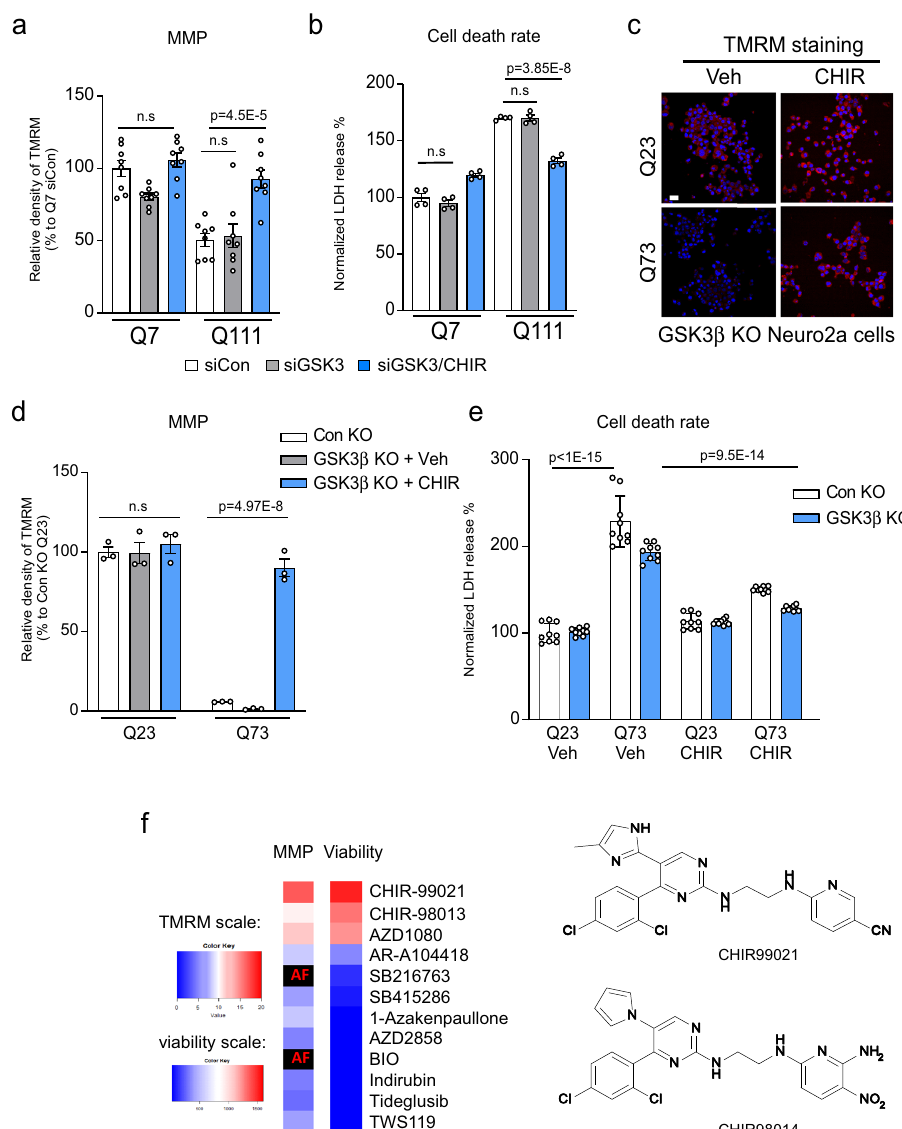
Fig. 3 The protective effects of CHIR99021 in HD is independent of GSK3. HdhQ7 and HdhQ111 cells were transfected with small interfering RNA (siRNA) control (siCon) or GSK3 (siGSK3) for 3 days, followed by CHIR99021 (3 µ M) treatment for 48 h. a Mitochondrial membrane potential (MMP) was examined by TMRM staining; quanti fi cation of TMRM density is shown ( n = 8). b Cell death was measured by lactate dehydrogenase (LDH) release after 16 h serum starvation ( n = 4). Neuro2a cells were transfected with vectors expressing control guide RNA (gRNA) or GSK3 β gRNA and Cas9. After con fi rming GSK3 knockout (Supplementary Fig. 3c), cells were transfected with Myc-tagged Q23-Htt (Q23) or Q73-Htt (Q73) constructs for 12 h, followed by a 2-day incubation with CHIR99021 (3 μ M) or vehicle (Veh). c Representative TMRM images of the indicated groups. Scale bar = 30 μ m. d Quanti fi cation of TMRM fl uorescence density is shown ( n = 3). e Cell death in the indicated groups was measured by LDH release ( n = 9). f Heat maps representing the effects of 12 GSK3 inhibitors on MMP (left) and cell viability following serum withdrawal (right). All molecules were assessed at 8 doses ranging from 0.078 to 10 μ M. MMP data are presented as the area under the dose – response curve of TMRM signal increase relative to DMSO-treated cells. Viability data are presented as the integral of the increase in non-apoptotic cells across all doses. AF: compound auto fl uorescence prevents an accurate assessment. TMRM scale: 0 – 20, viability scale: 0 – 1500. The CHIR99021 structure and its chemical analog, CHIR98014, are shown on the right. All values are reported as mean ± SEM and compared using one-way ANOVA with Tukey ’ s post hoc test in a , b , two-way ANOVA with Š ídák ’ s post hoc test in d , and two-way ANOVA with Dunnett ’ s post hoc test in e . Data are representative of at least three independent experiments. Exact p values are shown in the fi compared with the control groups (Supplementary Fig. 4b – d). littermates (Fig. 4d). Alpha-spectrin and p35 are known calpain CHIR99021 treatment corrected decreased CAST protein levels in substrates 39,40 . Levels of cleaved α -spectrin and p25, a cleaved product of p35, were increased in vehicle-treated R6/2 mice these HD cell cultures (Supplementary Fig. 4b – d), supporting our relative to vehicle-treated WT animals (Fig. 4d and Supplemen- earlier proteomics data (Fig. 4a, b). tary Fig. 4e), con fi rming calpain activation in HD mice. A 6-week In the striatum of vehicle-treated R6/2 mice, we con fi rmed that administration of CHIR99021 corrected CAST protein levels and CAST protein levels were decreased, whereas calpain I protein abrogated increased calpain I, p25, and cleaved α -spectrin levels levels were increased when compared with vehicle-treated WT